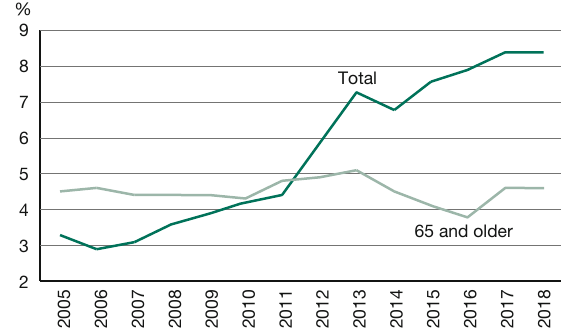
Source: Istat, 2020.